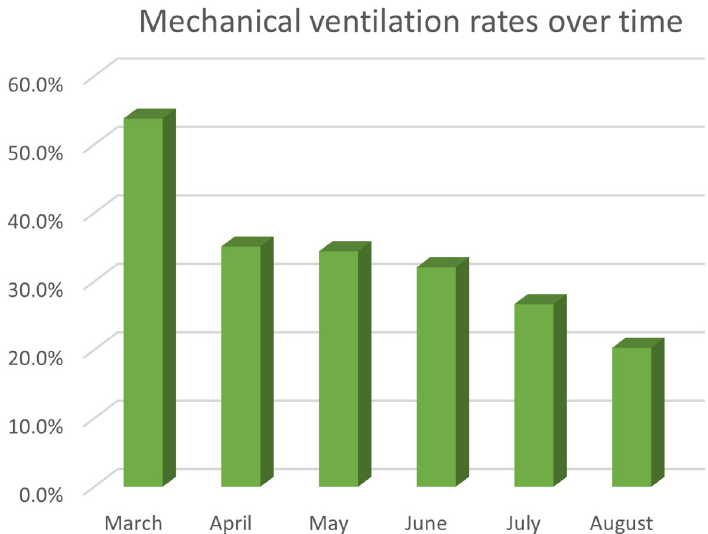
Fig 2. Mechanical ventilation rates over time in adults with COVID-19 and acute respiratory distress syndrome or acute respiratory failure. Mechanical ventilation rates over time from March 2020 to August 2020.